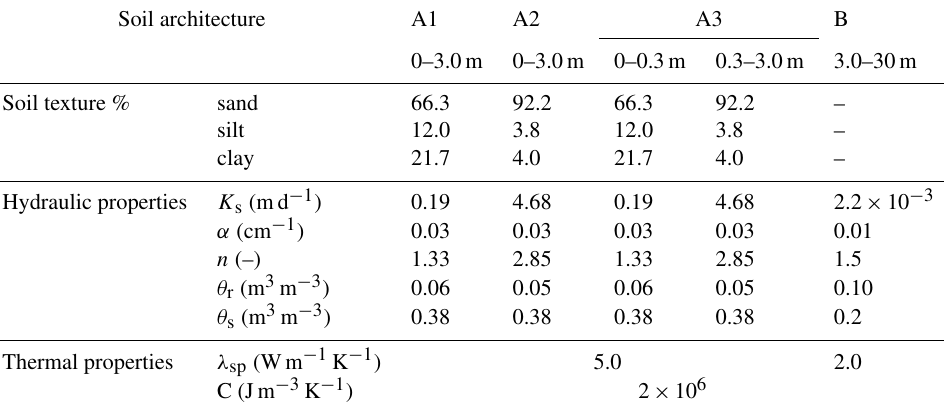
Table 1. Soil properties of shallow soils (A: 0–3.0m) and underlying soils (B: 3.0-30m) for three soil profiles (A1/B, A2/B and A3/B). K s is saturated hydraulic conductivity, α and n are van Genuchten parameters, θ r and θ s are residual and saturated soil water content, respectively, λ sp is thermal conductivity of soil particles and C is thermal capacity.